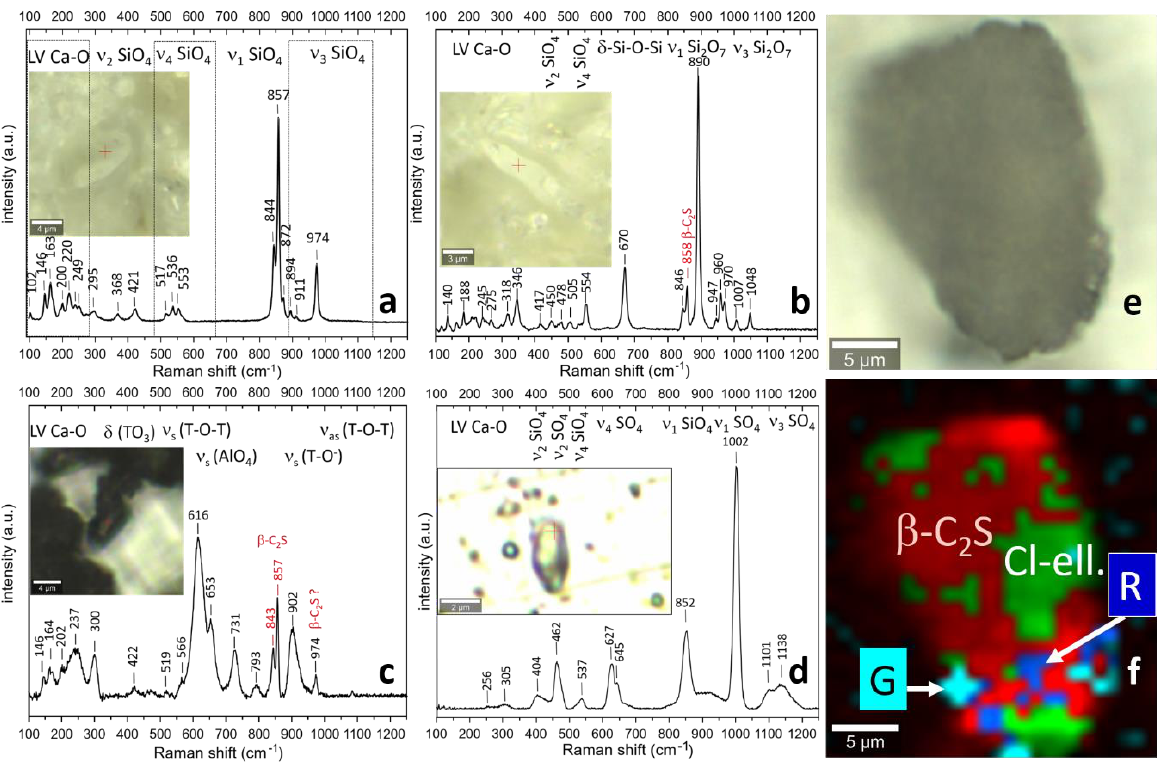
Figure 6 . Raman spectra of β -C 2 S ( a ), rankinite ( b ), melilite (gehlenite) ( c ), and chlorellestadite ( d ) in sample P. ( e ) Optical image of an aggregate of sample P calcined at 1200 °C. ( f ) Raman image of sample P. ( e ) Optical image of an aggregate of sample P calcined at 1200 ◦ C. ( f ) Raman image of the the phase distribution of β -C 2 S, chlorellestadite, rankinite (R), and mellilite (G). phase distribution of β -C 2 S, chlorellestadite, rankinite (R), and mellilite